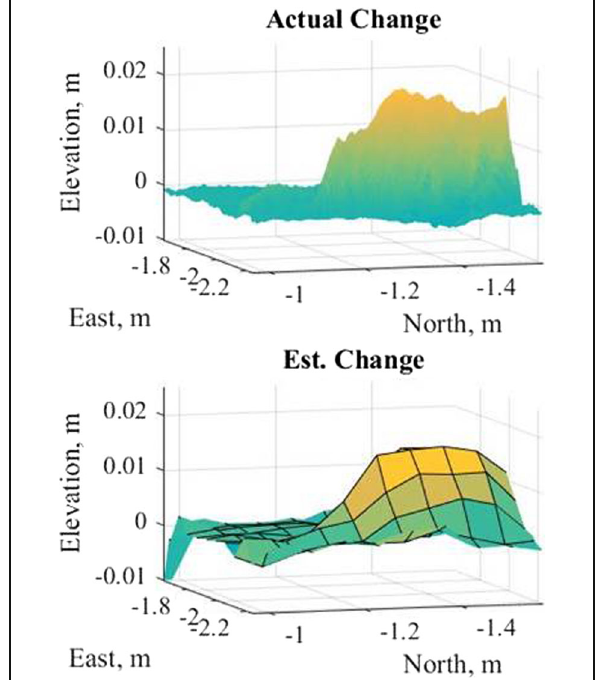
Fig. 10 Actual vs. estimated terrain change in lab-simulated fan model. Upper: actual terrain change x ref ; lower: estimation in states